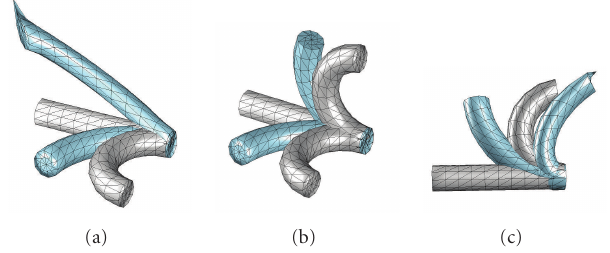
Figure 14: Edits of a bar model with the translational control.